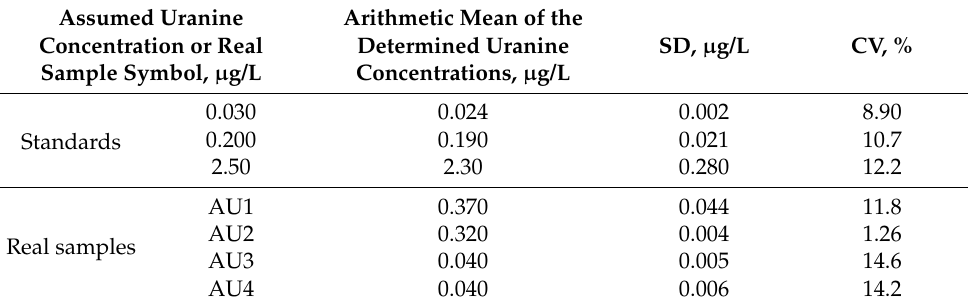
Table 6. Evaluation of the reproducibility of the method for determination of uranine by HPLC/FLD based on the results obtained for standard solutions and real